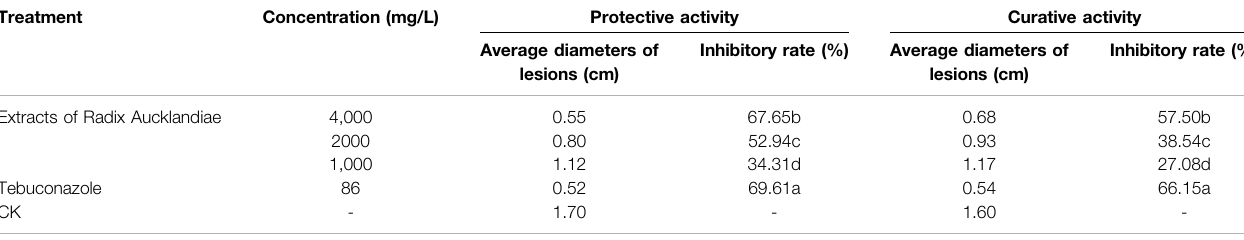
TABLE 5 | Control effect of extracts of Radix Aucklandiae on citrus anthracnose in vivo at 7 days after treatment. Treatment